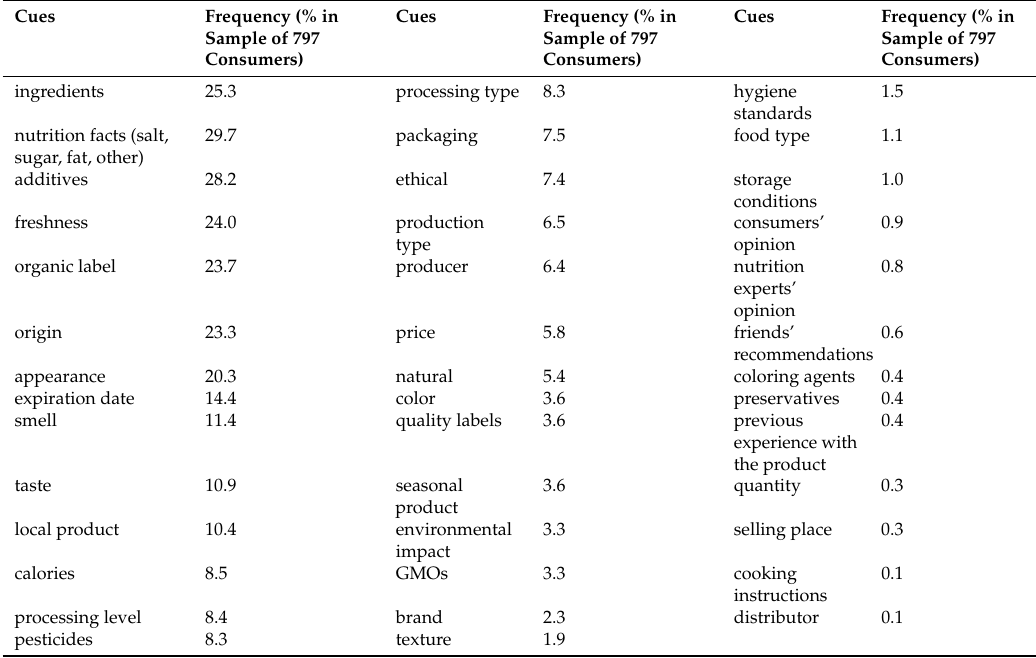
Table 6. Percentage of tested consumers who declared they often used a specific cue for the evaluation of food healthiness (unaided